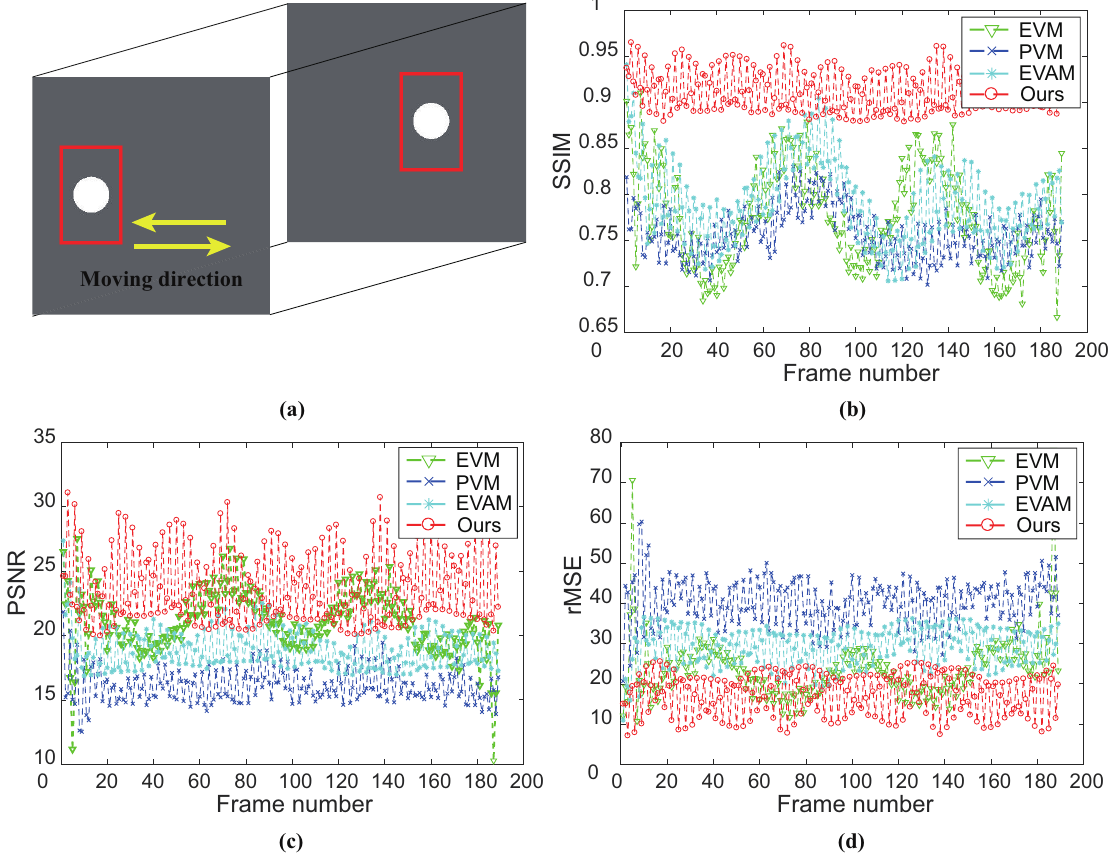
Figure 10. ( a ) Sequences from SynVideo2; and ( b ) SSIM with ground-truth for each magnified frame (top). Here, SSIM is calculated only by the pixels inside the red rectangle (see ( a )). Similarly, PSNR and rMSE are measured by the same sites included ( a ), as shown in ( c , d ). SSIM shows that our algorithm has better structural similarity. PSNR and rMSE imply that our algorithm can magnify small signals with few magnification artifacts over other examined